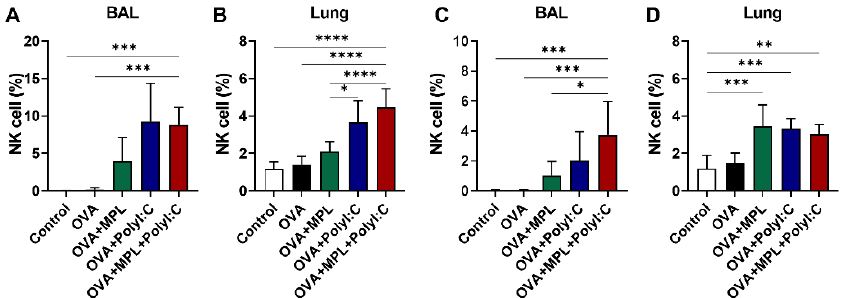
Figure 1. NK cell recruitment after intranasal immunizations of OVA with adjuvants. C57BL/6 mice were intranasally immunized with ovalbumin alone or plus MPL, poly I:C or MPL + poly I:C. The immunizations were given two times with 2 weeks interval (prime and boost). At day 1 post prime ( A , B ) and boost ( C , D ) immunizations, NK cell population in BAL and Lung cells were analyzed by flow cytometry. CD45 + CD3 − CD49 + cells were gated as NK cells. All data show the mean ± SD. Statistical analysis between groups were performed by One-way ANOVA and Tukey’s multiple comparison test. * p < 0.0332, ** p < 0.0021, *** p < 0.0002 and **** p <